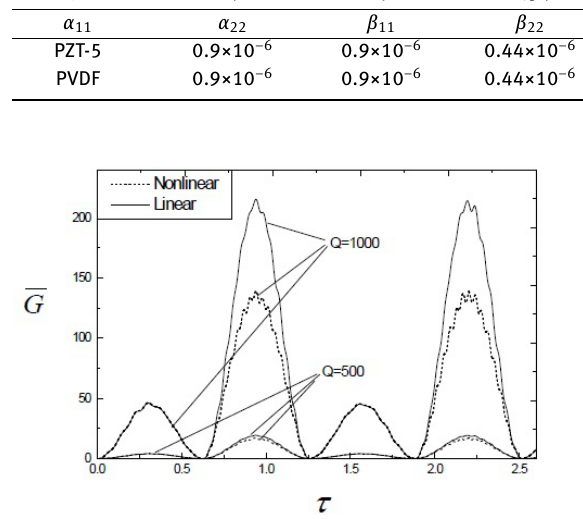
Fig. 3. Effect of geometric nonlinear on energy release rate of delam- inated piezoelectric shell.